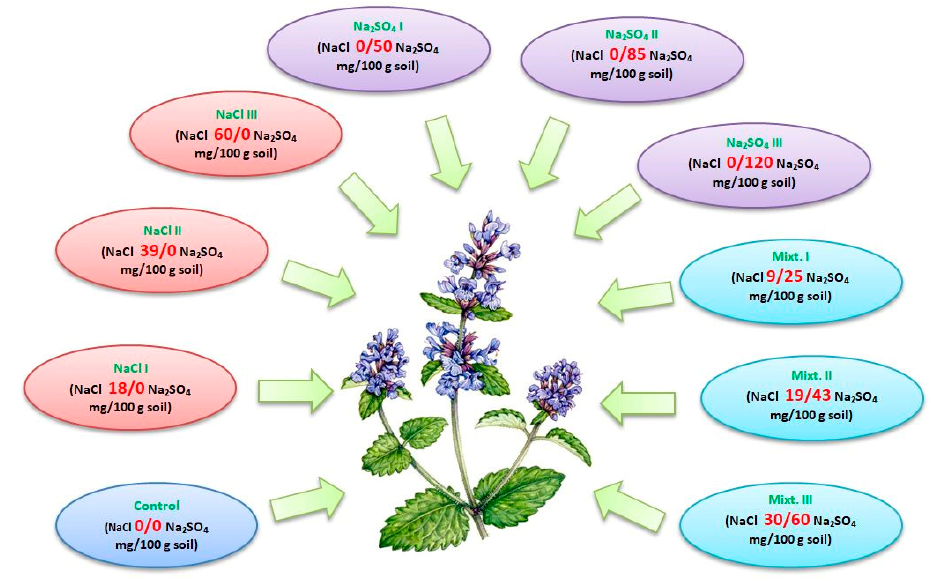
Figure 10. Experimental design scheme.